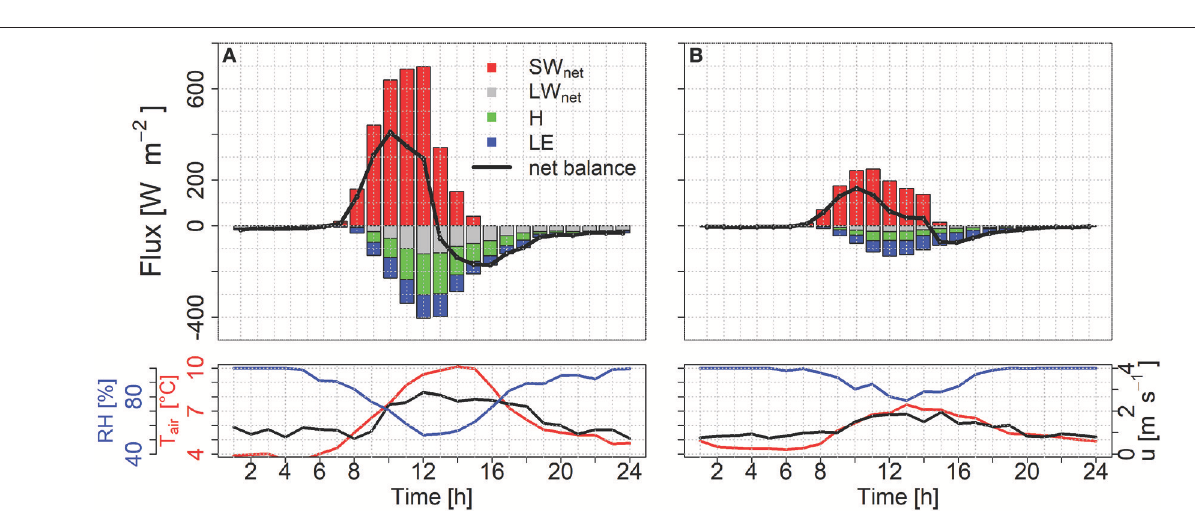
FIGURE 5 | Median fluxes and meteorological data on (A) clear and (B) overcast days, with the net balance of all fluxes shown as a black